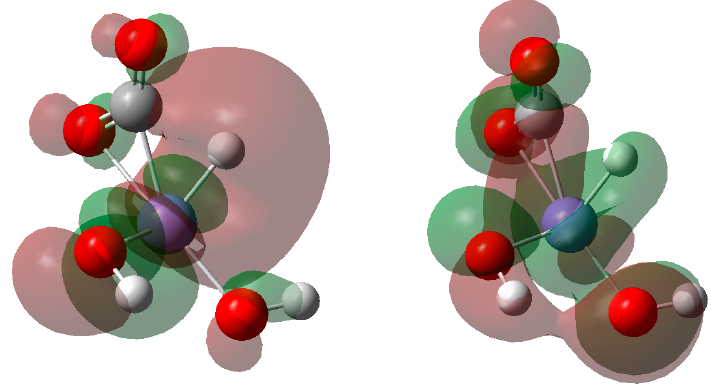
Figure 5. HOMO and LUMO orbital shapes of the transition state.